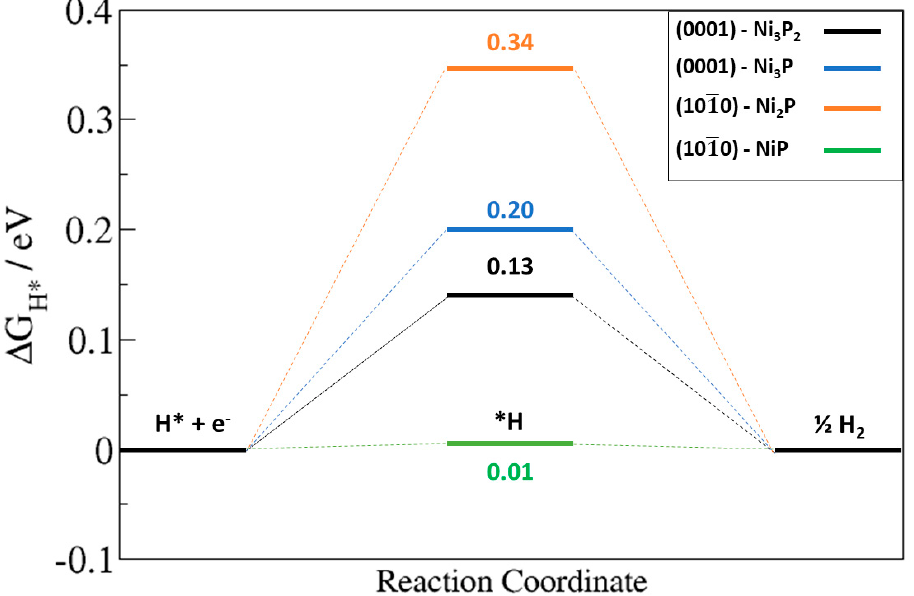
Figure 9. The optimum Gibbs free of hydrogen adsorption ( | ∆ G H* | ) on (0001) and (1010) surfaces of Ni 2 P.